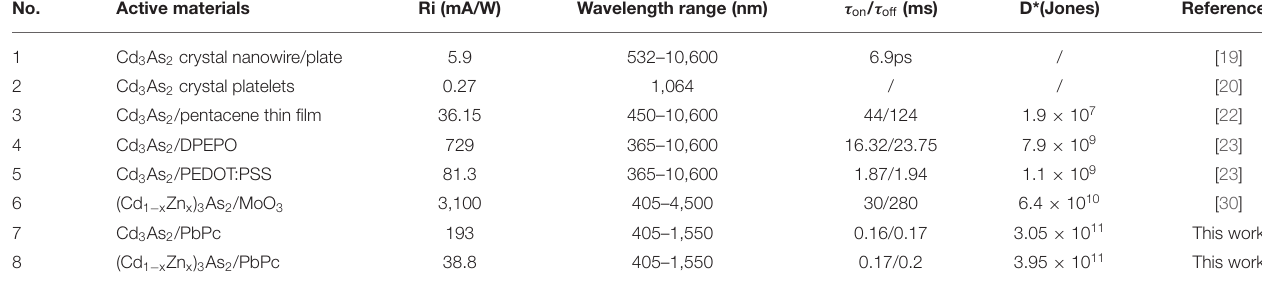
TABLE 1 | Performance of photodetectors based on Cd 3 As 2 material.